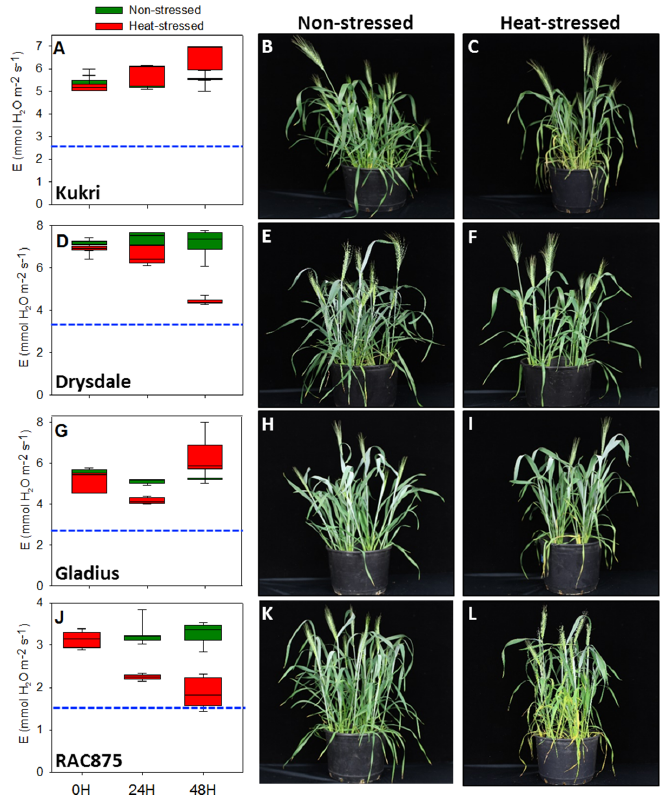
Figure 1. Transpiration rate is maintained under moderate heat stress by Australian summer wheat varieties. Physiological and phenotypical effects on varieties Kukri ( A – C ), Drysdale ( D – F ), Gladius ( G – I ), and RAC875 ( J – L ) are shown. Box plots show the central tendency and dispersion of the transpiration rate among all Australian cultivars. Green and red box plots represent non ‐ and heat ‐ stressed plants, respectively. Blue bars show 50% transpiration rate of non ‐ stressed plants. 15–20 plants of each line were examined.